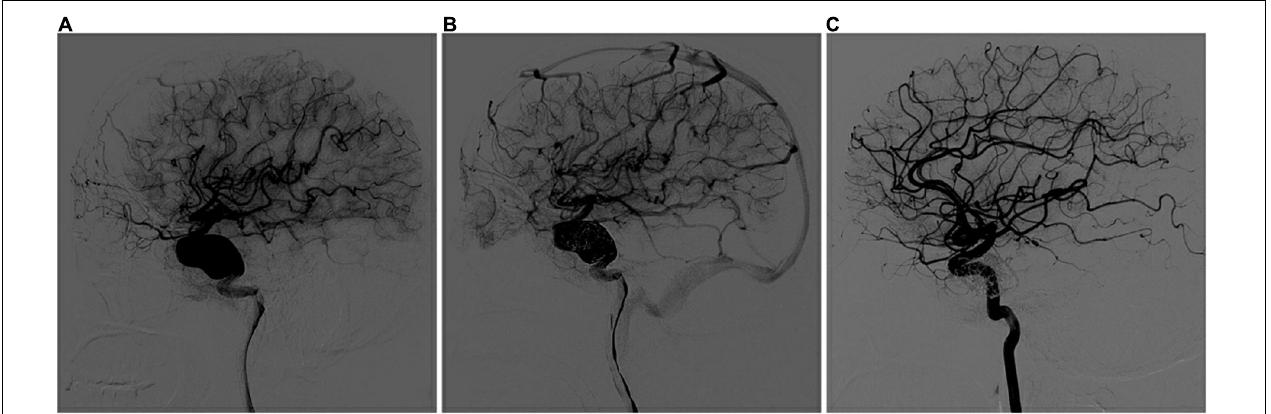
FIGURE 1 | Multi-PEDs for the treatment of a fusiform aneurysm (telescope technique). (A) Digital subtraction angiography (DSA) identified a fusiform aneurysm with a proximal diameter of 4.87 mm and a distal diameter of 4.38 mm in the internal carotid artery before operation. (B) After three pipeline embolization